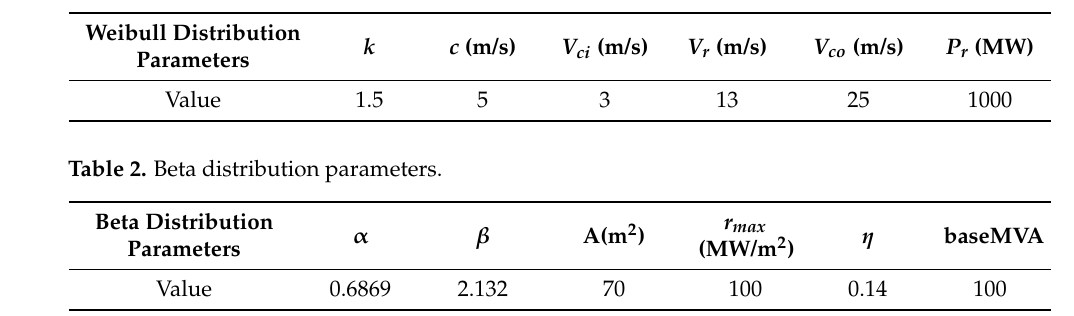
Table 1. Weibull distribution parameters.